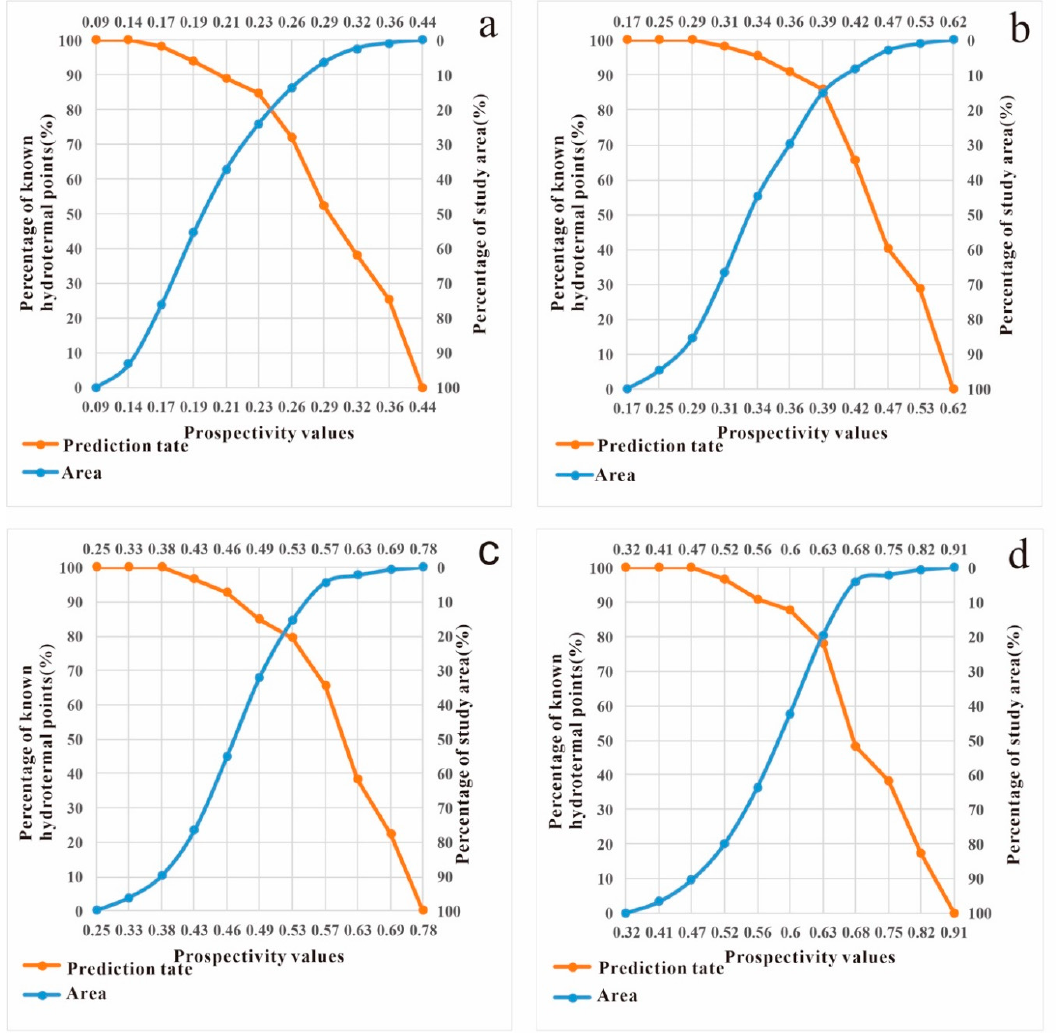
Figure 5. Comparison of different gamma values in fuzzy logic model. ( a ) γ = 0.85, ( b ) γ = 0.90, ( c ) γ = 0.93, ( d ) γ = 0.95.